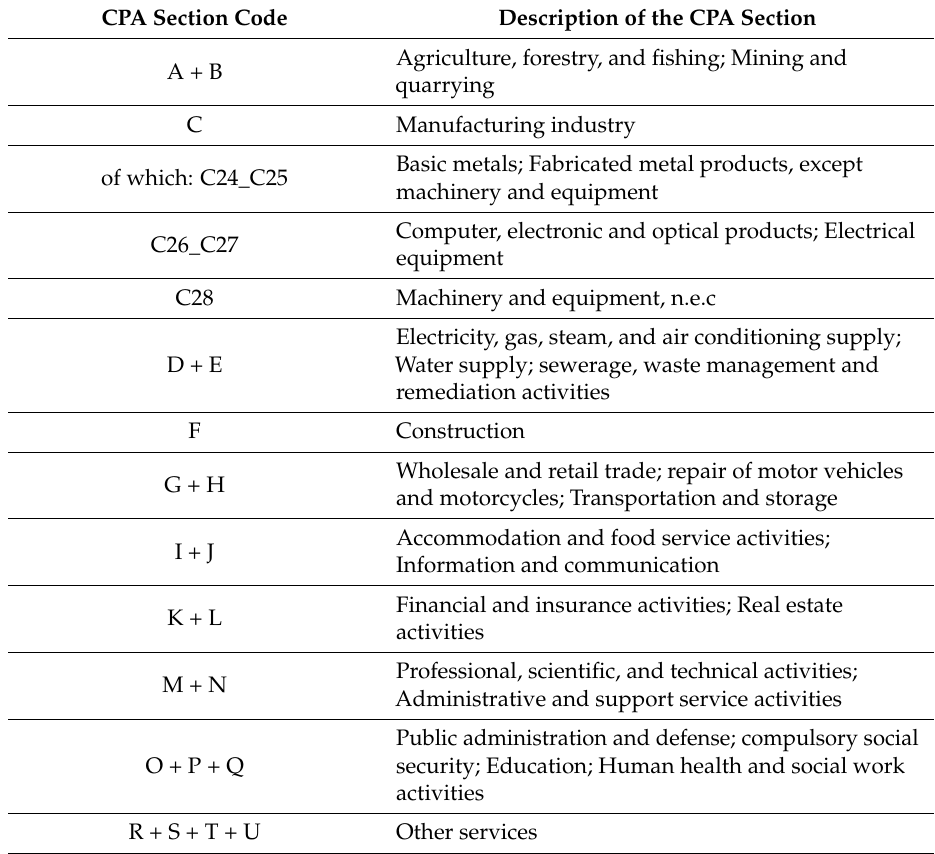
Table A2. Classification of the economic sectors for which the total effects are